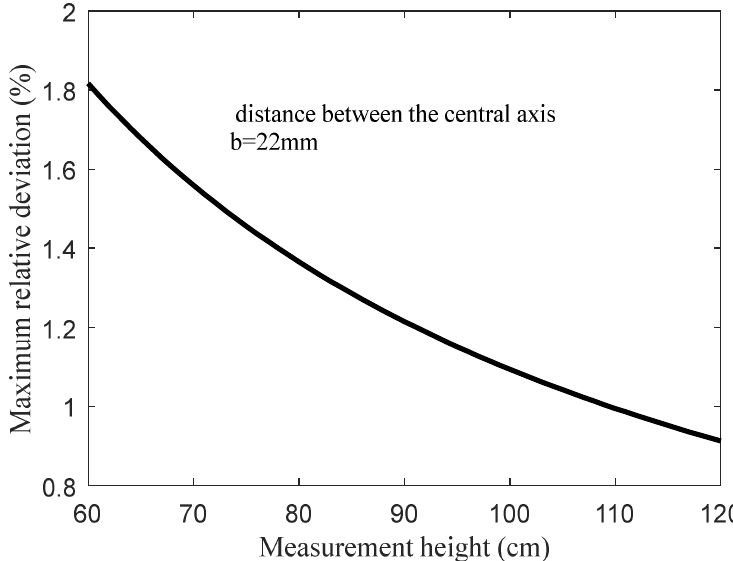
Figure 11. The maximum relative deviation of incident light intensity between the two optical detection paths when the measurement height changes.